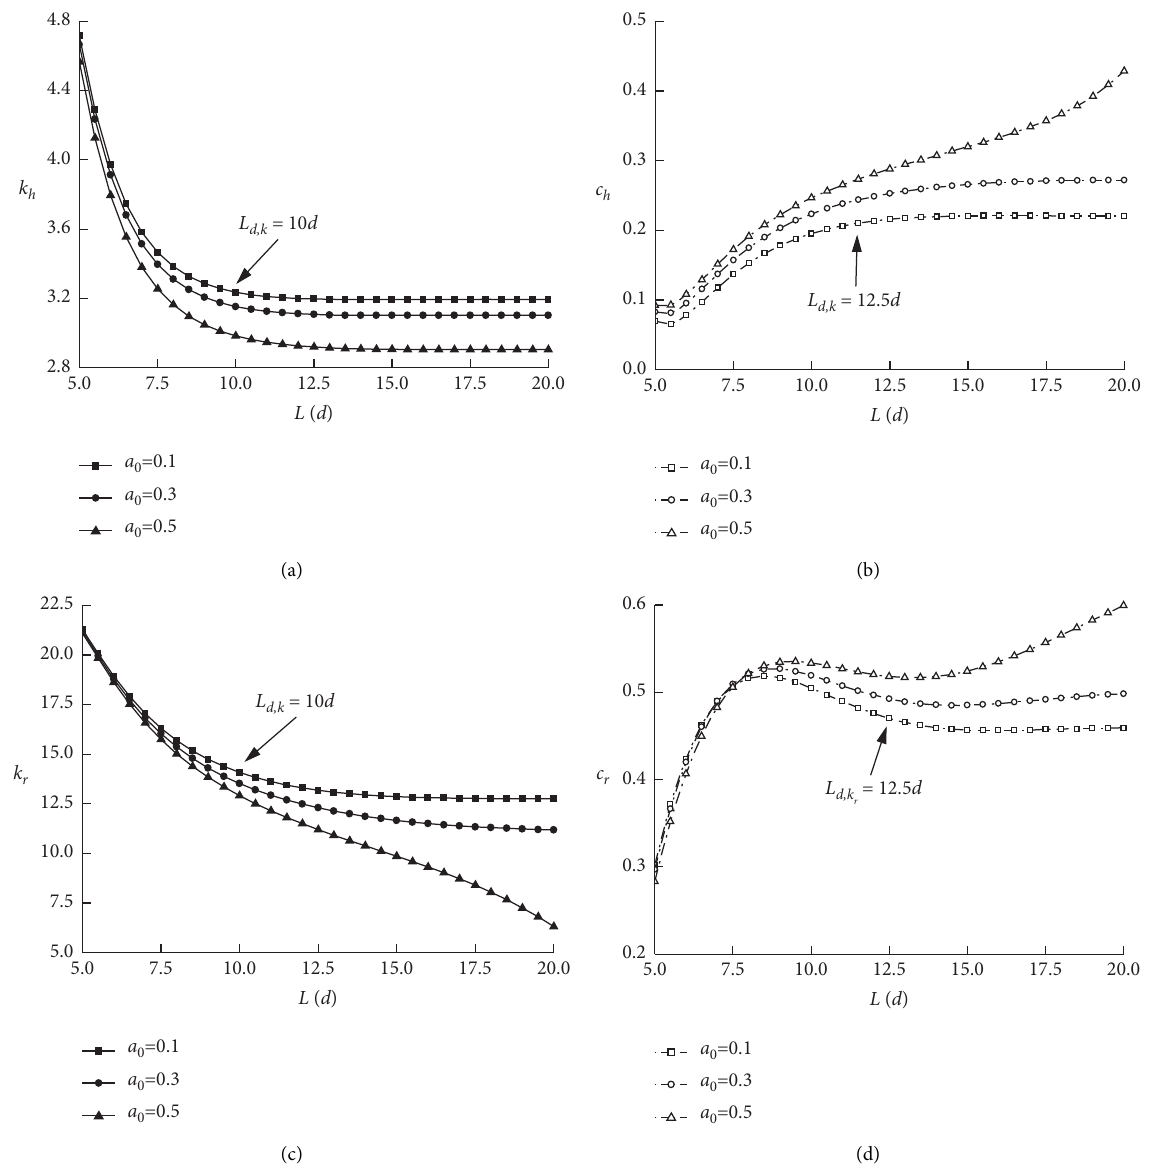
Figure 6: Variation in complex impedance with slenderness ratio and dimensionless frequency. (a) Horizontal dimensionless dynamic stiffness. (b) Horizontal dimensionless dynamic damping. (c) Sway dimensionless dynamic stiffness. (d) Sway dimensionless dynamic